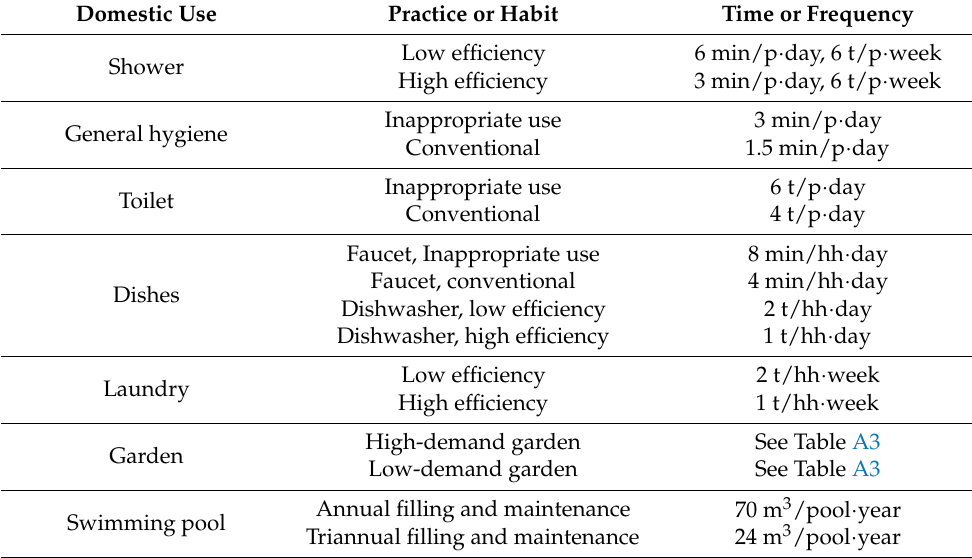
Table 4. Water practices considered for